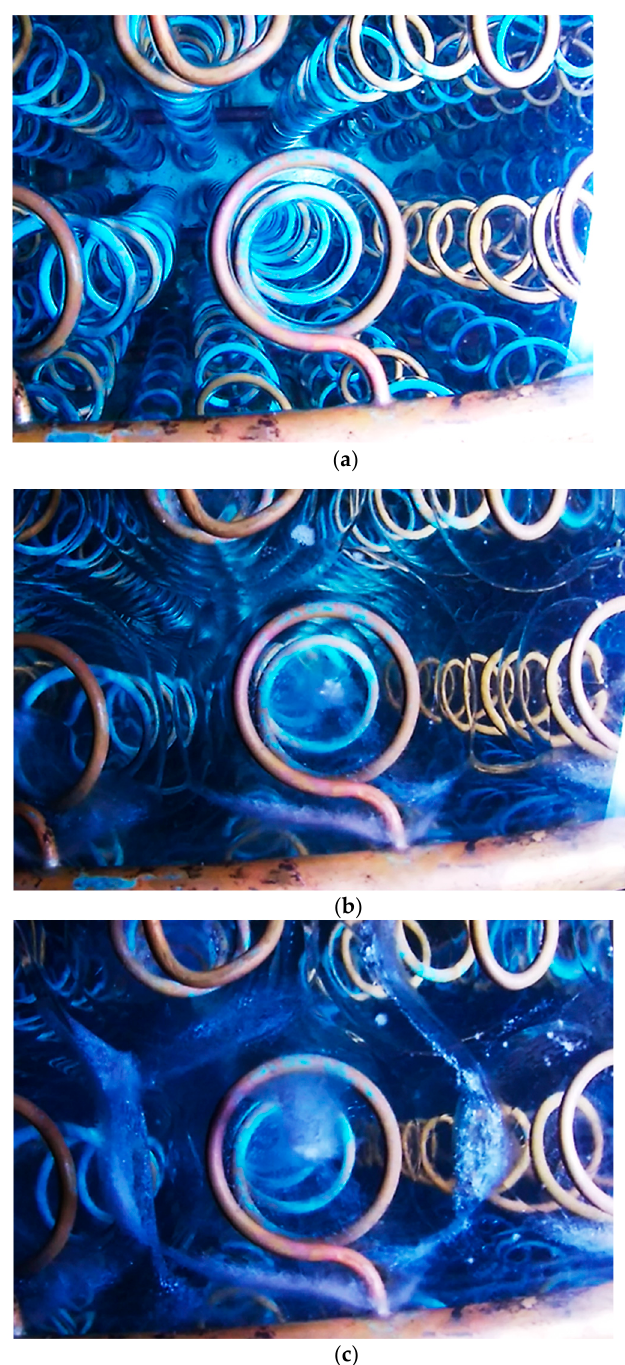
Figure 7. Picture of the icing condition at ( a ) the second hour, ( b ) fifth hour, and ( c ) eighth hour.